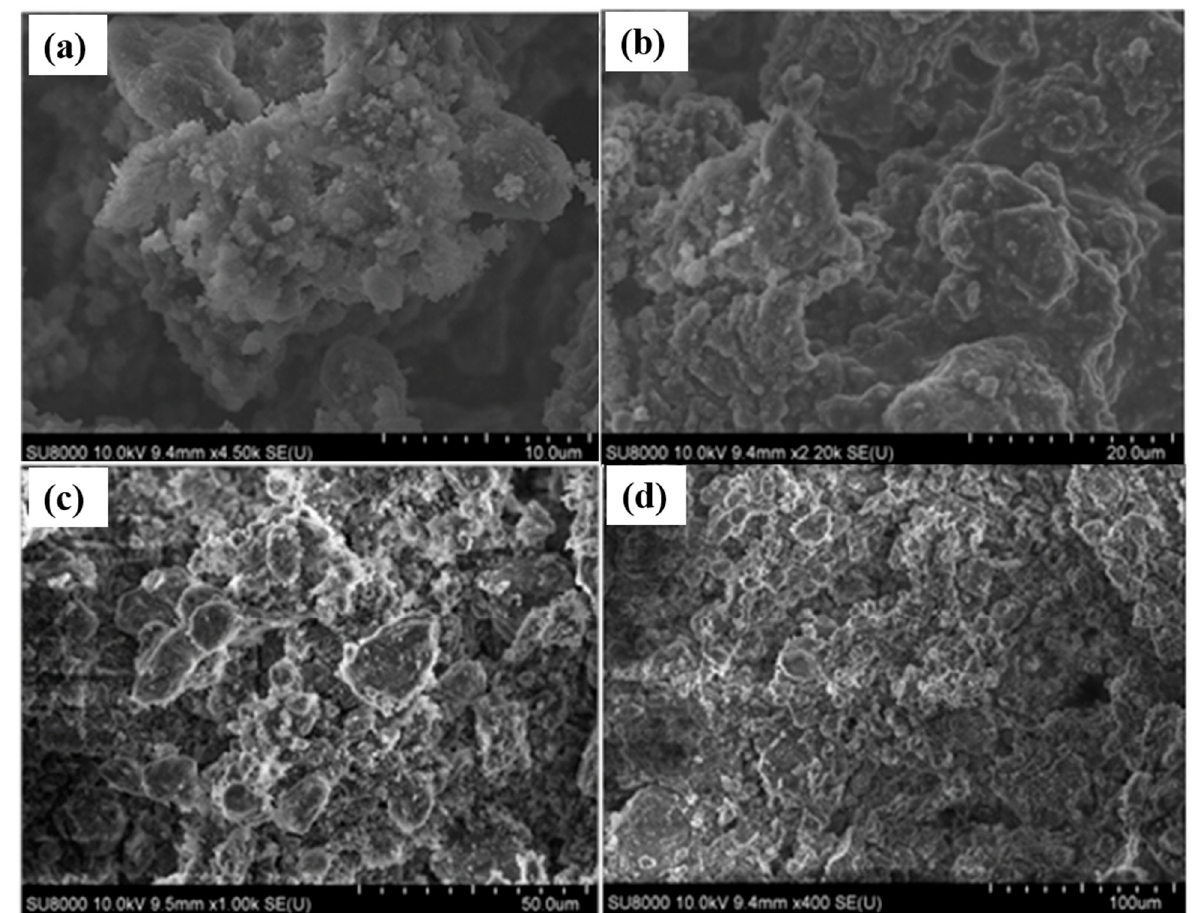
Figure 3. FESEM images of surface morphologies for the composite LLCZN/PEO/LiPF 6 powder for solid-state electrolyte before cycling at different magnifications of ( a ) 10.0 μ m, ( b ) 20.0 μ m, ( c ) 50 μ m, and ( d ) 100 μ m.